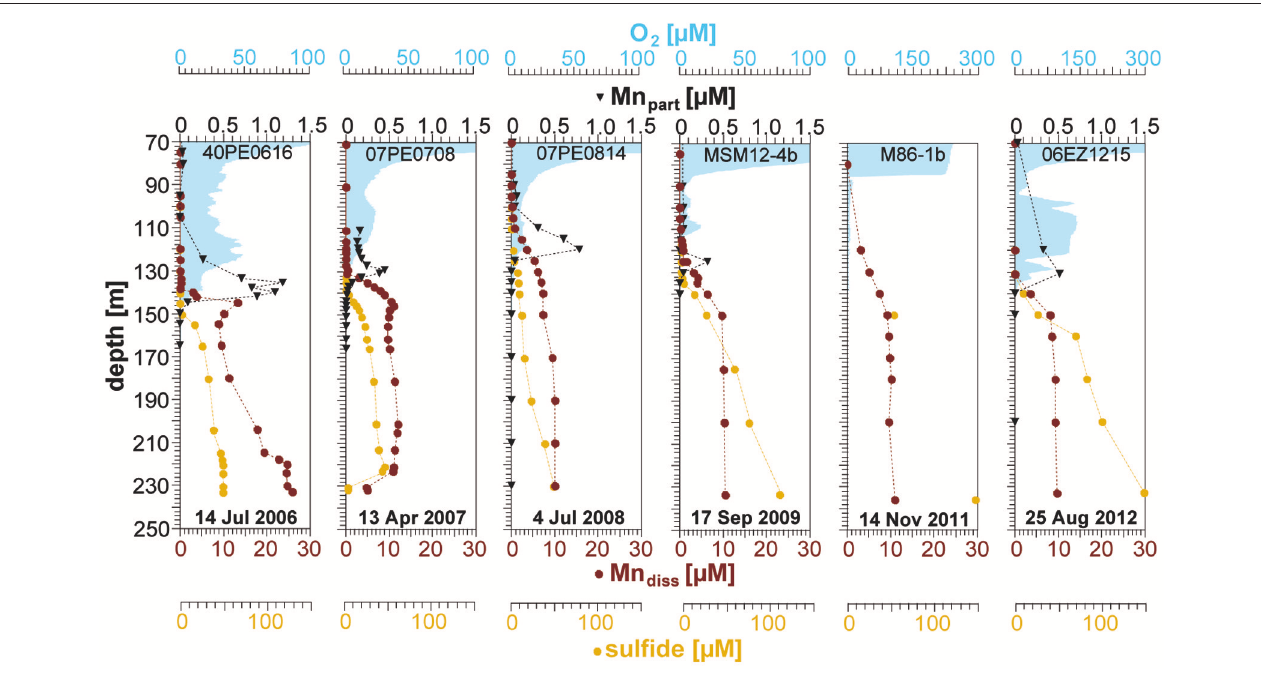
FIGURE 2 | Water column profiles of O 2 , dissolved and particulate Mn, and total sulfide as determined in samples obtained from station 271 in the central Gotland Basin between 2006 and 2012.